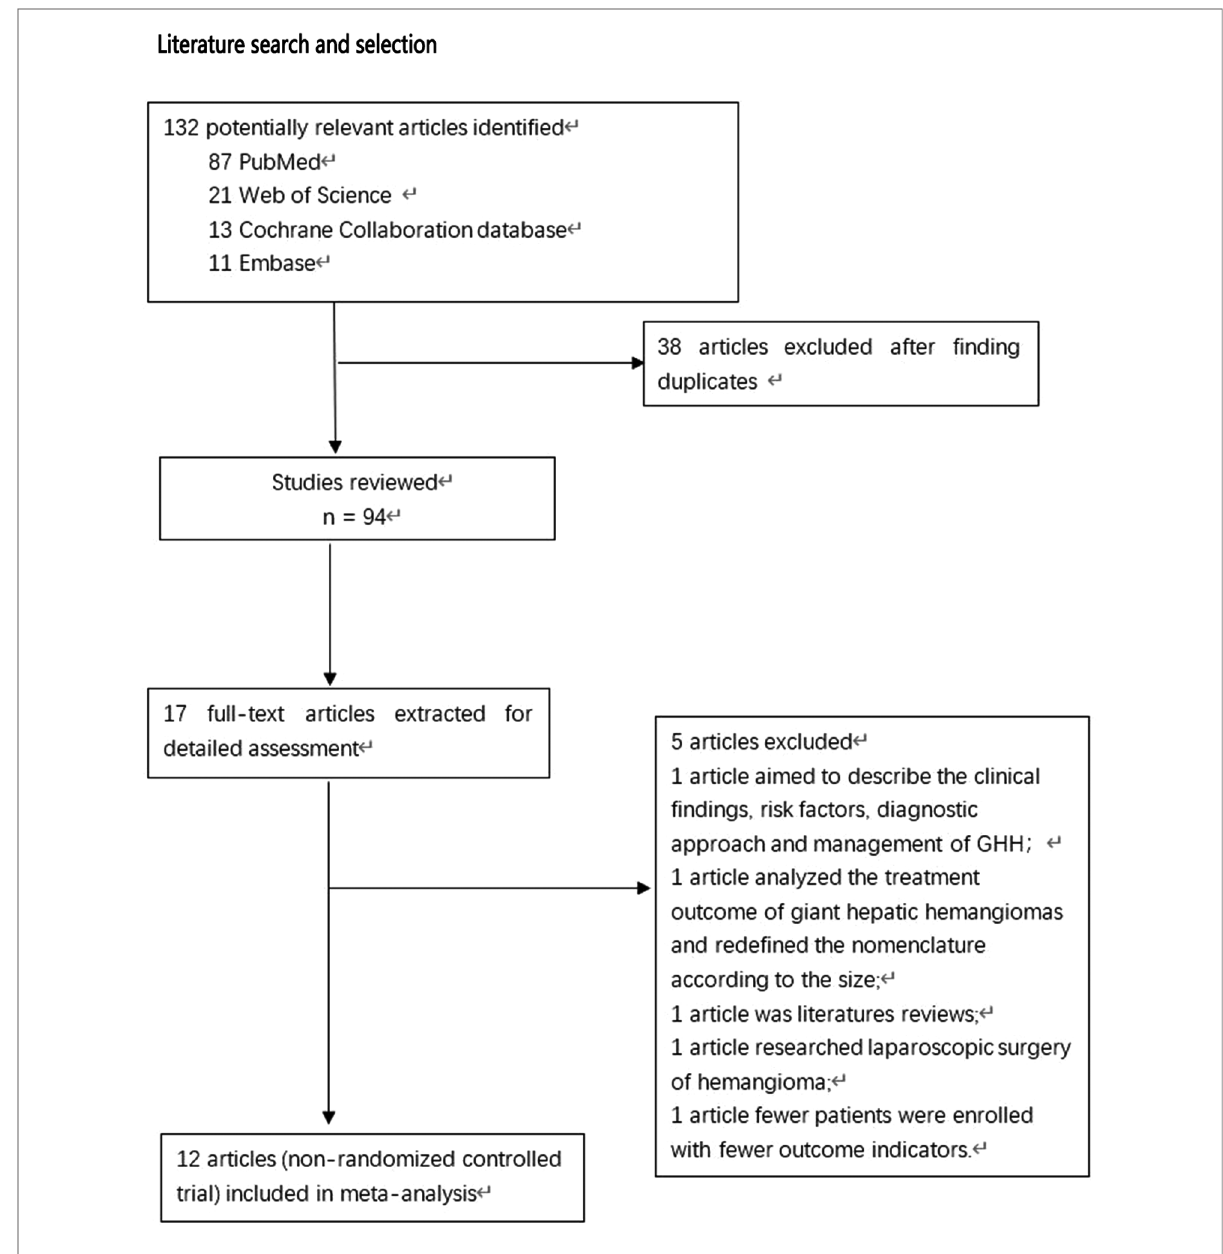
FIGURE 1 PRISMA fl